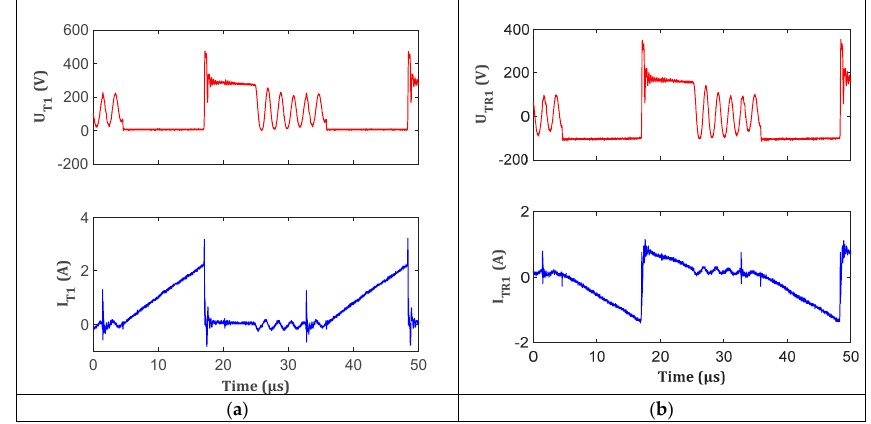
Figure 20. Experimental waveforms of the input transistor (T1) voltage and current ( a ) and corresponding transformer TR1 voltage and current ( b ) (P = 200 W).